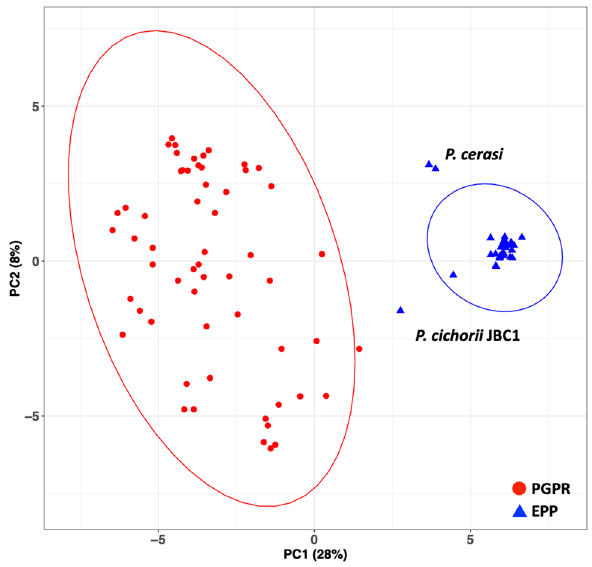
Figure 3. Principal component analysis based on GP-SND content as variables. The fraction of the variance is given in parentheses. P. cichorii JBC1 and two strains of P. cerasi are outside 95% confidence ellipse of the EPP group.